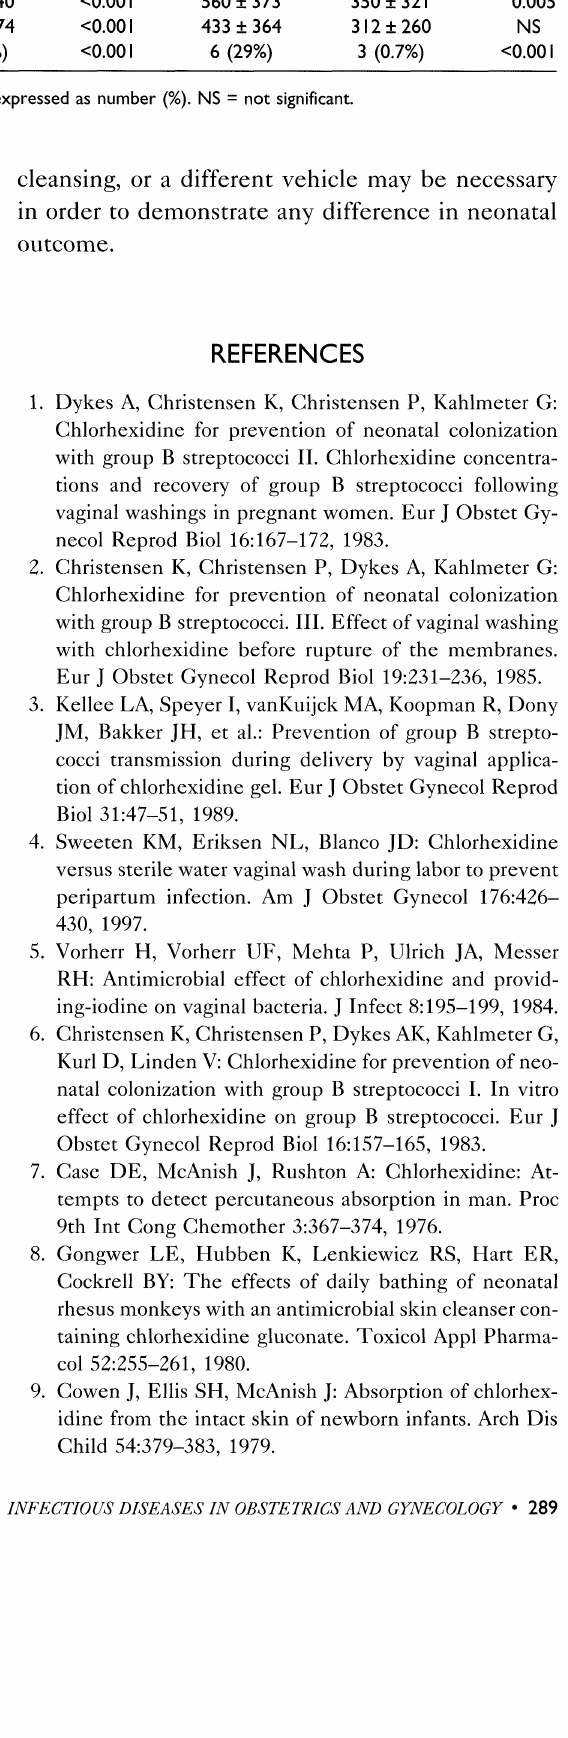
TABLE 2. Labor characteristics and use of antibiotics in the neonate compared to the incidence of IAI Chlorhexidine Controls IAI No IAI IAI No IAI Characteristic (n 23) n 434) P (n 21) (n 445) Length of ruptured membranes (min) 653 + 408 405 + 540 <0.001 560 + 373 350 + 321 0.005 Vaginal wash to delivery (min) 559 + 235 326 + 274 <0.001 433 + 364 312 + 260 NS 3 (0.7%) <0.001 Antibiotics 8 (35%) 7 (I.6%) <0.001 6 (29%) Data are expressed as mean + S.D., except for antibiotic data, which are expressed as number (%). NS not significant. ence in the number of neonates receiving